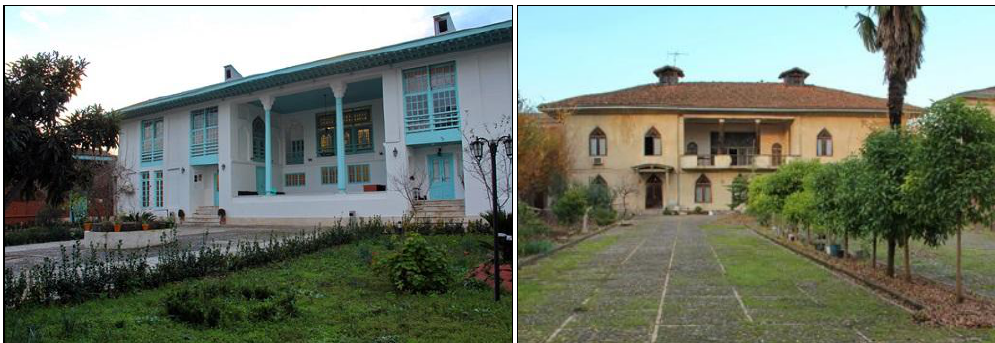
Figure 8. Culture House of Guilan Figure 9. Samiee